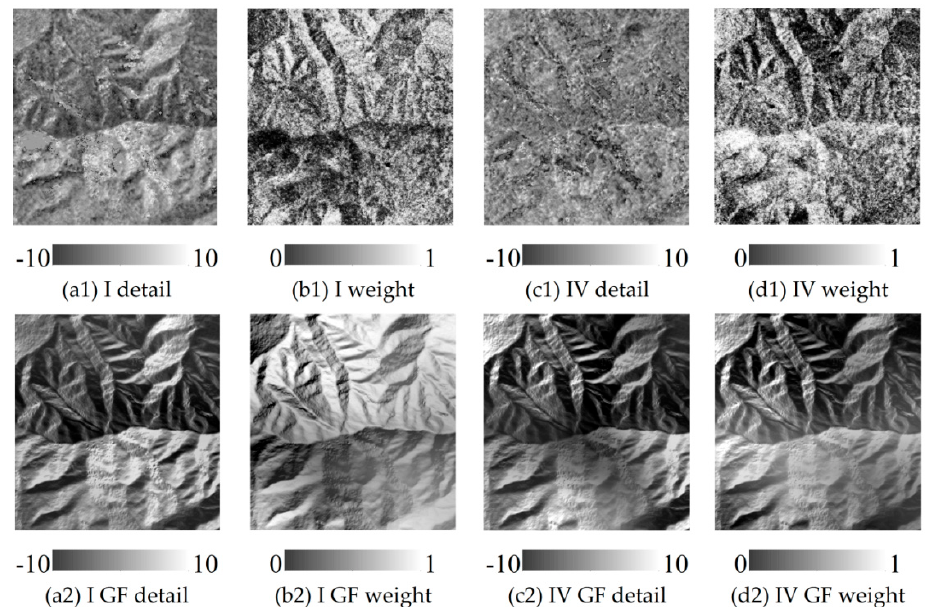
Figure 5. Detail maps and weight maps of Interferograms I ( B n = 251 m, ascending) and IV ( B n = 237 m, descending). ( a1 , a2 ) and ( b1 , b2 ) are the detail maps and weight maps of Interferogram I, respectively; ( c1 , c2 ) and( d1 , d2 ) are the detail mapsand weight mapsof InterferogramIV, respectively; ( a1 , b1 , c1 , d1 ) are the original detail maps and weight maps; and ( a2 , b2 , c2 , d2 ) are the guided filtered detail maps and weight